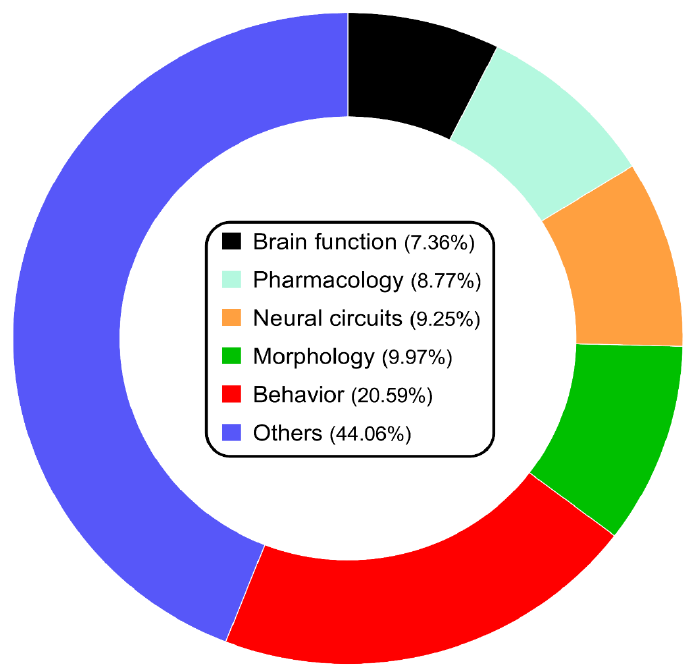
Figure 3. Graphical representation of publications using zebrafish as the animal model in neuroscience (of total taken as 100%) divided into several different major topics.